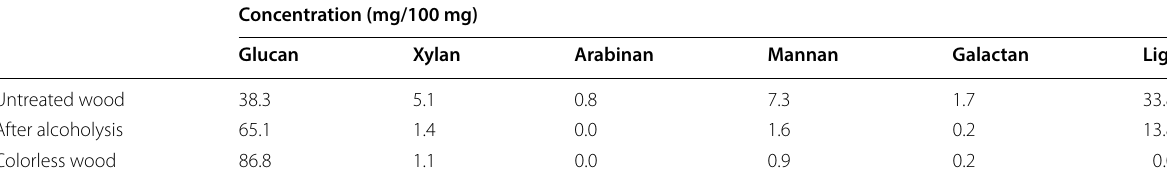
Table 2 Chemical component analysis of the wood before and after 2 step chemical treatment